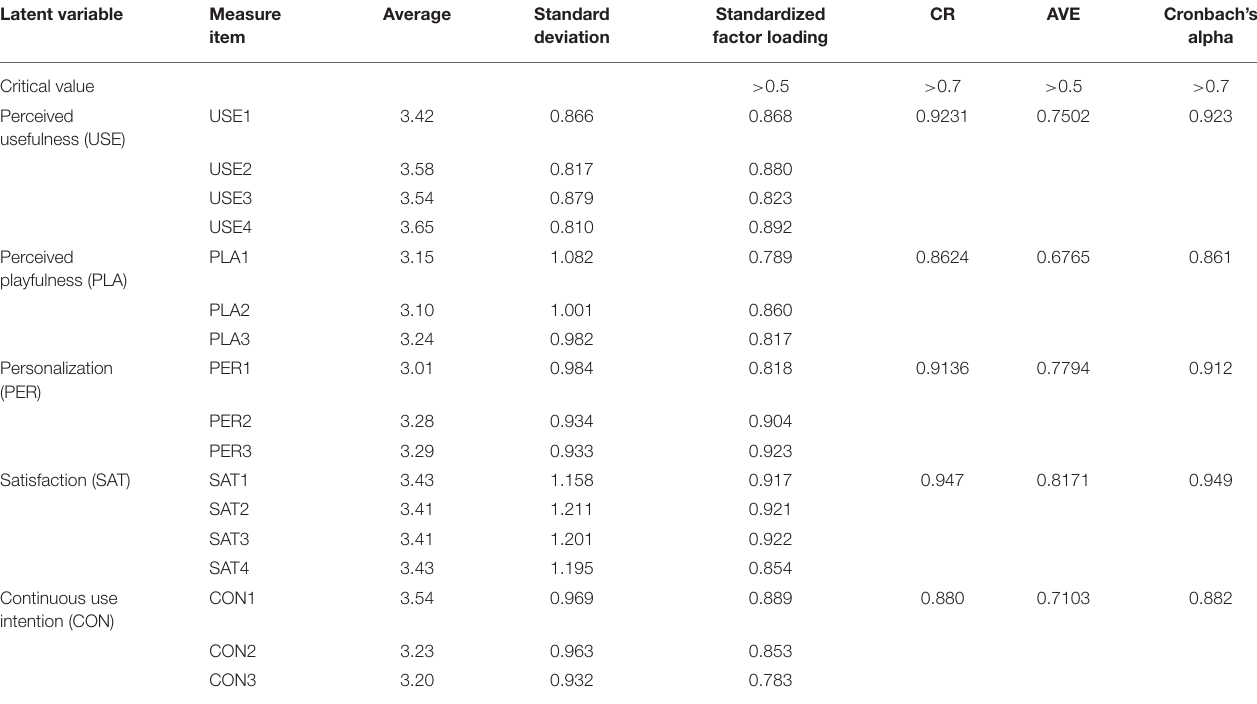
TABLE 1 | Results of confirmatory factor analysis.